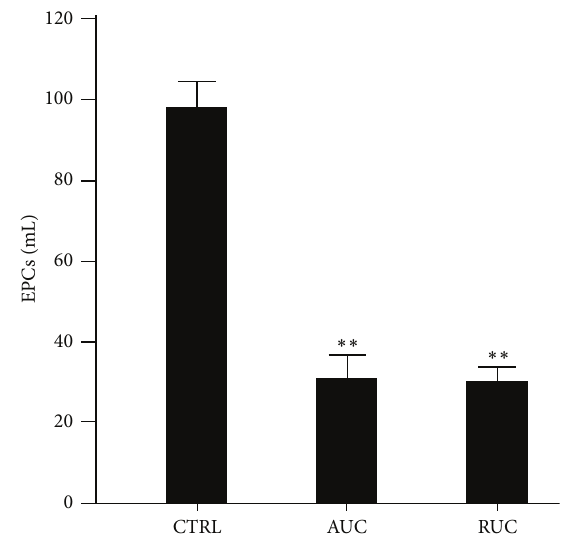
Figure 1: Circulating endothelial progenitor cells (EPCs) levels in each study group (CTRL = controls; AUC = active ulcerative colitis; RUC = remitting ulcerative colitis). Data are shown as means ± standard error means. Statistical significance was calculated with a univariate ANOVA and post hoc test for multiple comparisons. Statistical difference in AUC and RUC groups with respect to controls is indicated by ∗∗ ( 𝑃 < 0,001 ).